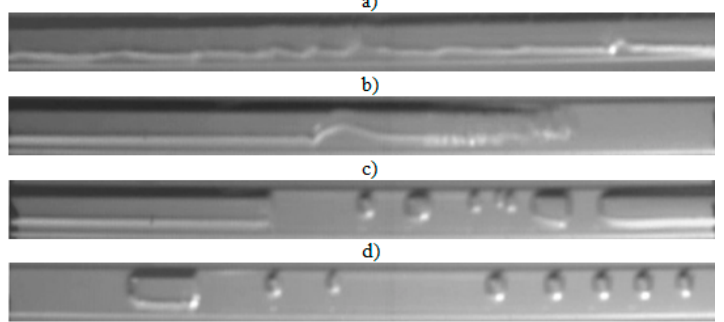
Figure 8. Experimental results of visualization research on HFE7100 refrigerant condensation in a minichannel with an internal diameter d h = 0.8 mm: ( a ) annular ‐ wavy flow G = 3539 kg/m 2 s, x = 0.23, ϕ = 0.67, t s = 59 °C; ( b ) slug flow G = 1180 kg/m 2 s, x = 0.11, ϕ = 0.45, t s = 59 °C; ( c ) plug flow G = 1180 kg/m 2 s, x = 0.07, ϕ = 0.33, t s = 59 °C; ( d ) bubbly flow G = 1769 kg/m 2 s, x = 0.06, ϕ = 0.29, t s = 59 °C.